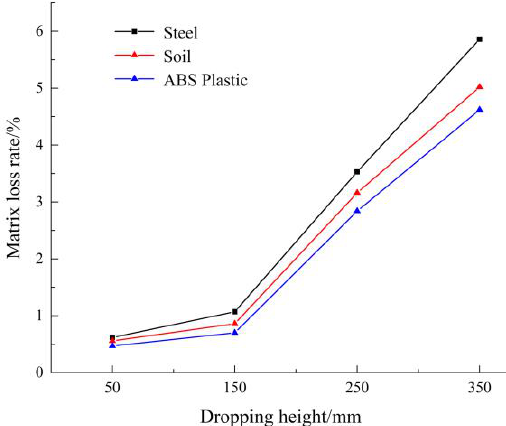
Figure 6. The relationship between matrix loss and drop height of plug seedlings with three contact materials.